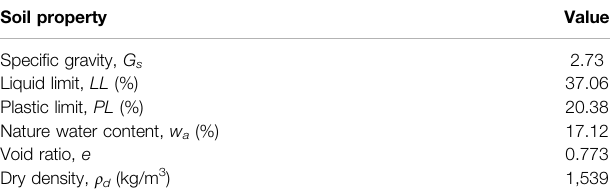
TABLE 1 | Physical properties of